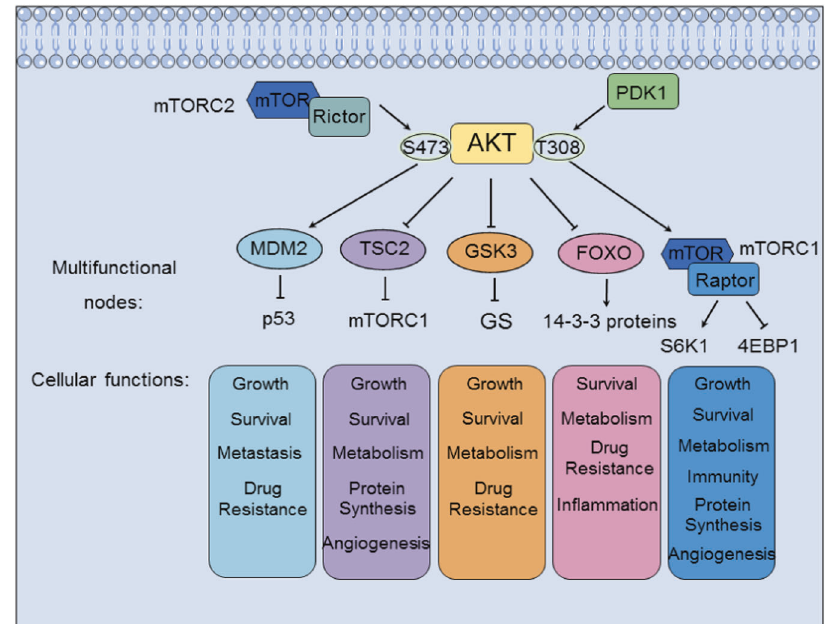
Fig. 2 Downstream effectors of the PI3K/Akt signaling pathway and their cellular functions. The activation of Akt signaling can promote (arrows) or inhibit (blocking arrows) the phosphorylation of downstream effectors. Downstream regulation by Akt contributes to many cellular processes, including tumor growth, tumor survival, tumor cell proliferation, cancer immunity, cancer metabolism and cancer